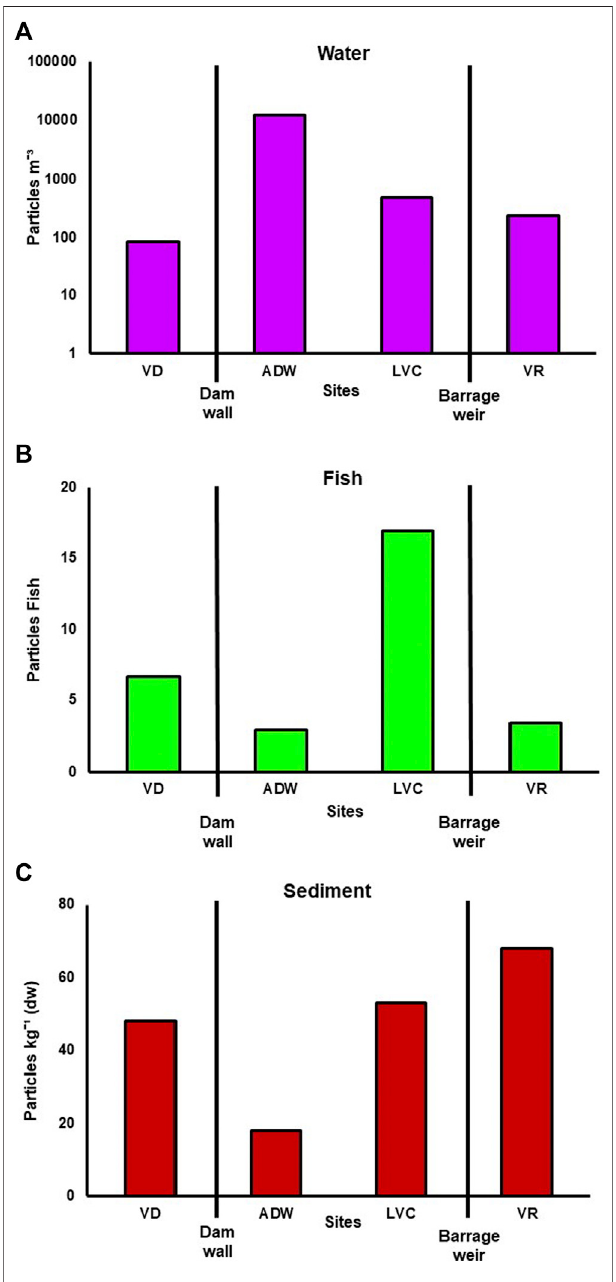
FIGURE 3 | Bar graphs of the mean total number of microplastics found in water [ (A) -logarithmic scale], fi sh (B) and sediment (C) . dw — dry weight.